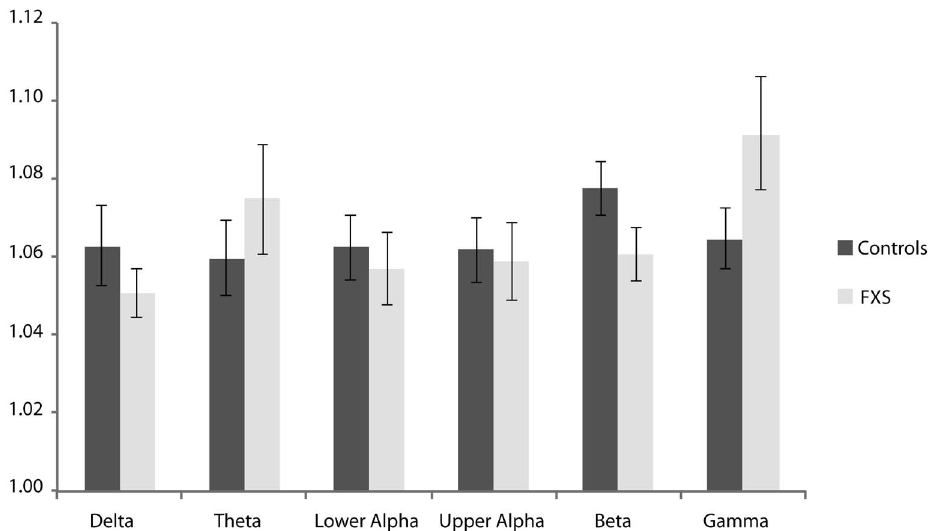
Figure 4. Mean normalized clustering coefficients over all epochs for FXS and controls participants in the delta (0.05–4), theta (4– 8 Hz), lower alpha (8–10 Hz), upper alpha (10–13 Hz), beta (13–30 Hz), and gamma (30–45 Hz) frequency range. Error bars represent standard error of the mean.